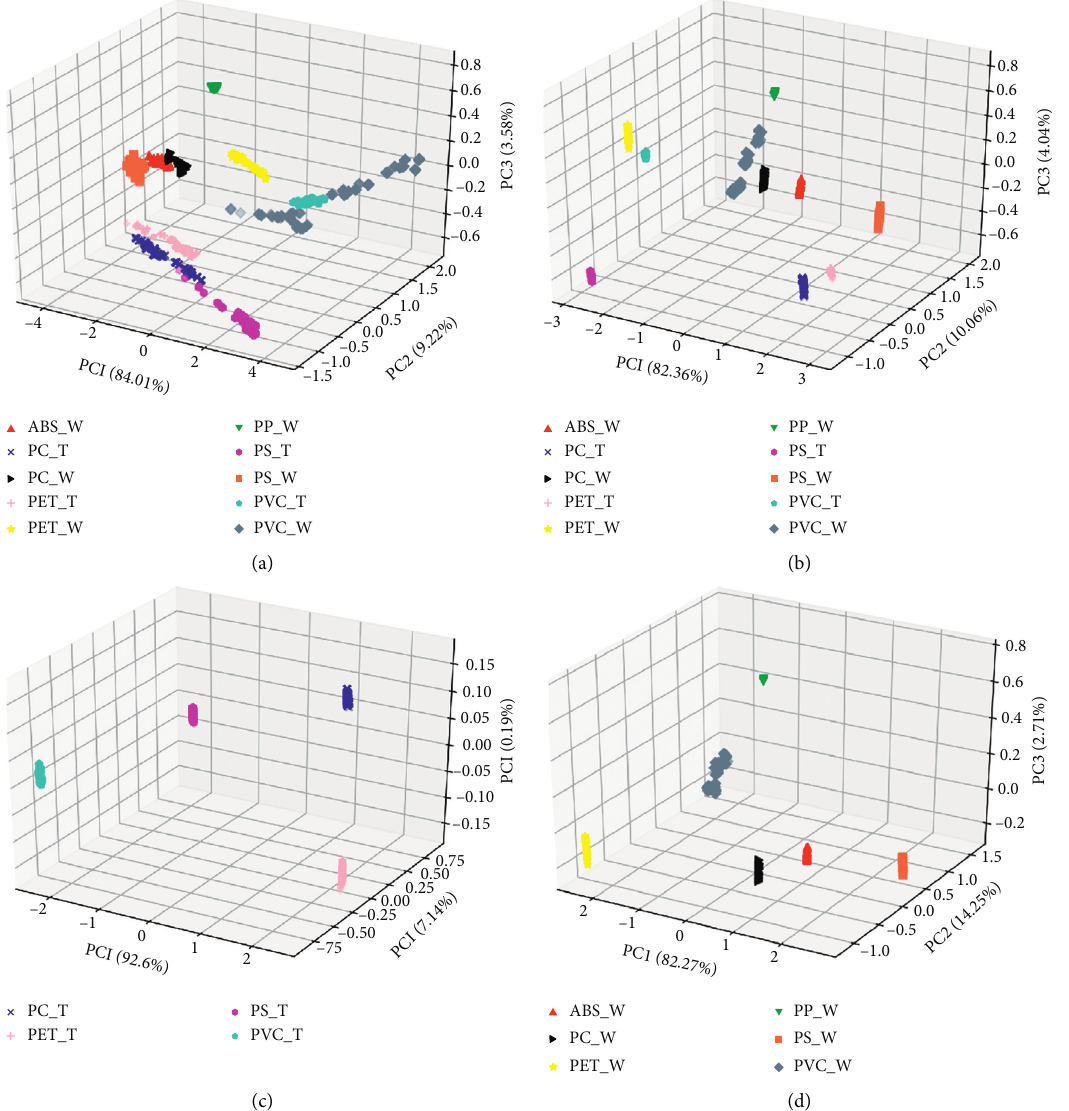
Figure 3: (a) PCA score plot of raw mixed dataset; PCA score plot of data preprocessed by MSC (b) mixed dataset; (c) transparent dataset; (d) white